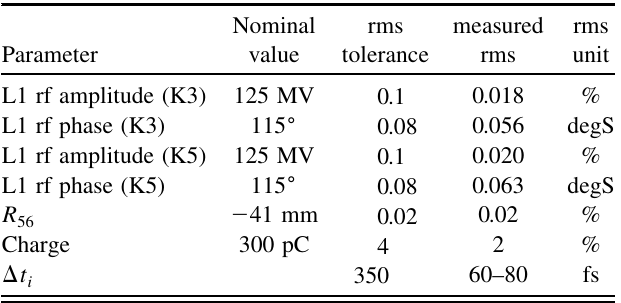
TABLE I. Nominal settings, rms short-term stability toleran- ces, and measured rms values of the rf amplitudes, rf phases, charge and initial arrival-time jitter ( (cid:1) t i ) for the FERMI bunch compression system.